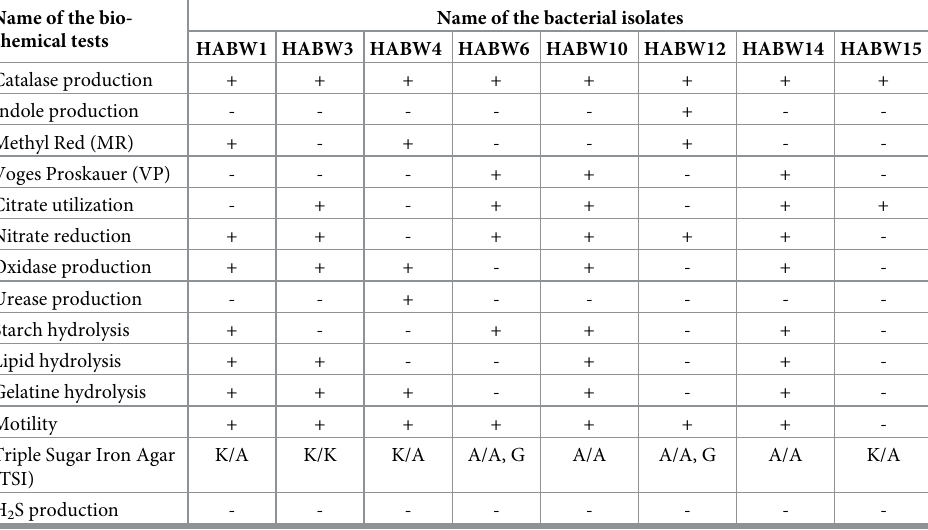
+ = Positive, − = Negative, K = Alkaline, A = Acidic, G = Gas.